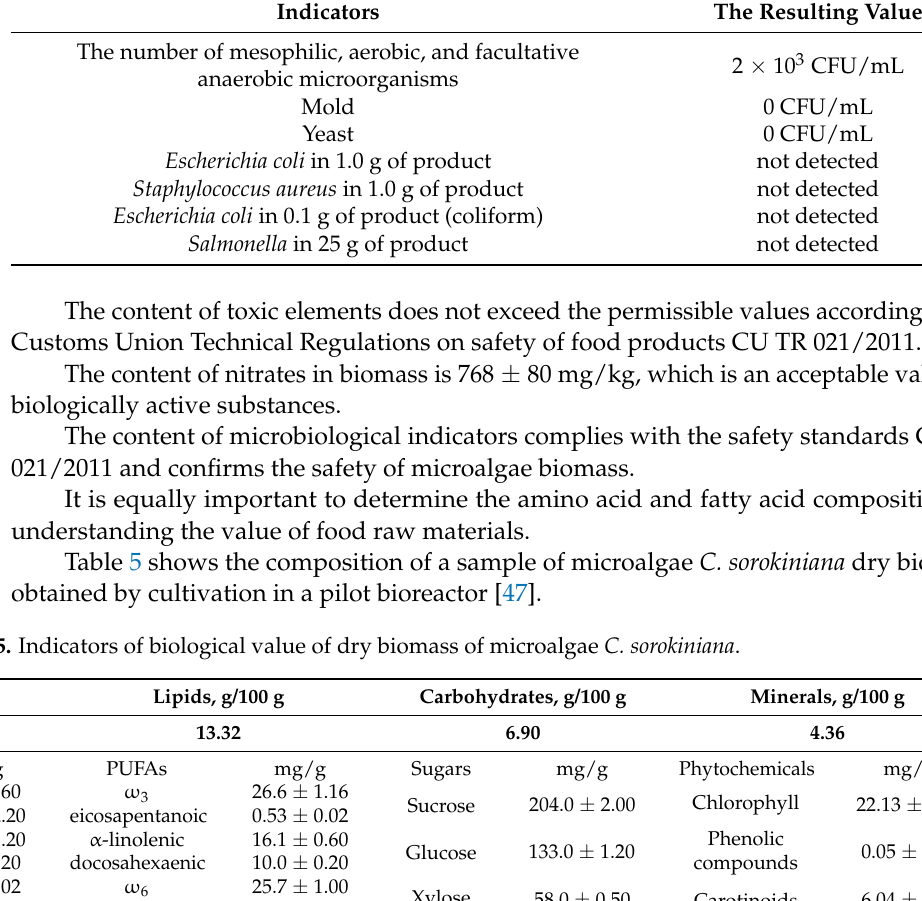
Table 4. Microbiological indicators of the biomass safety of the microalgae C. sorokiniana . Indicators The Resulting Value The number of mesophilic, aerobic, and facultative